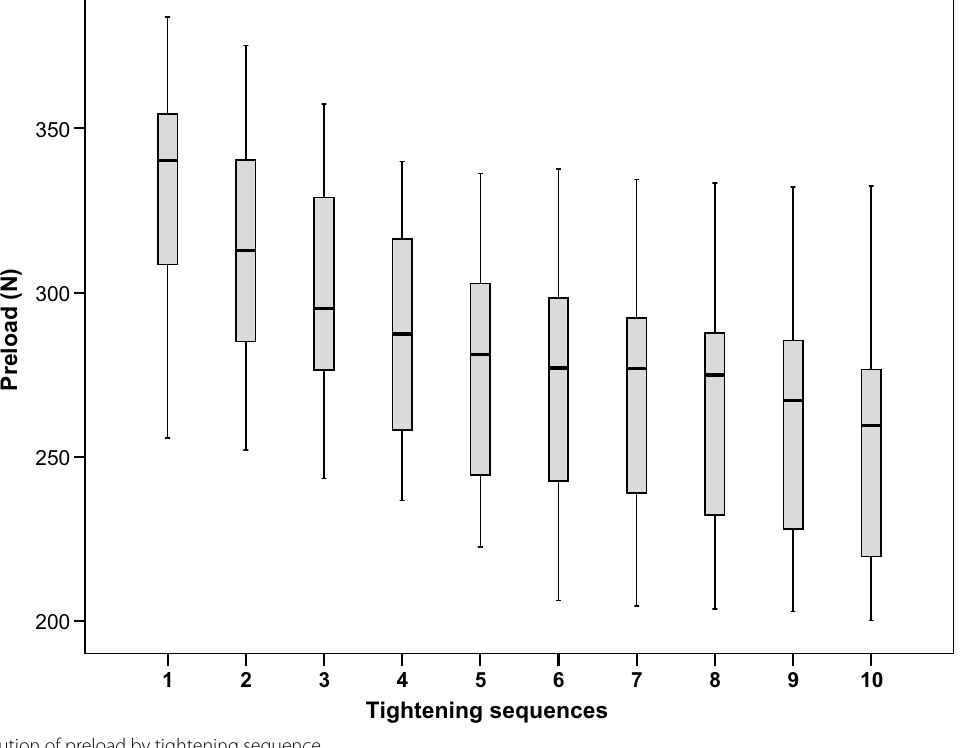
Fig. 5 Distribution of preload by tightening sequence